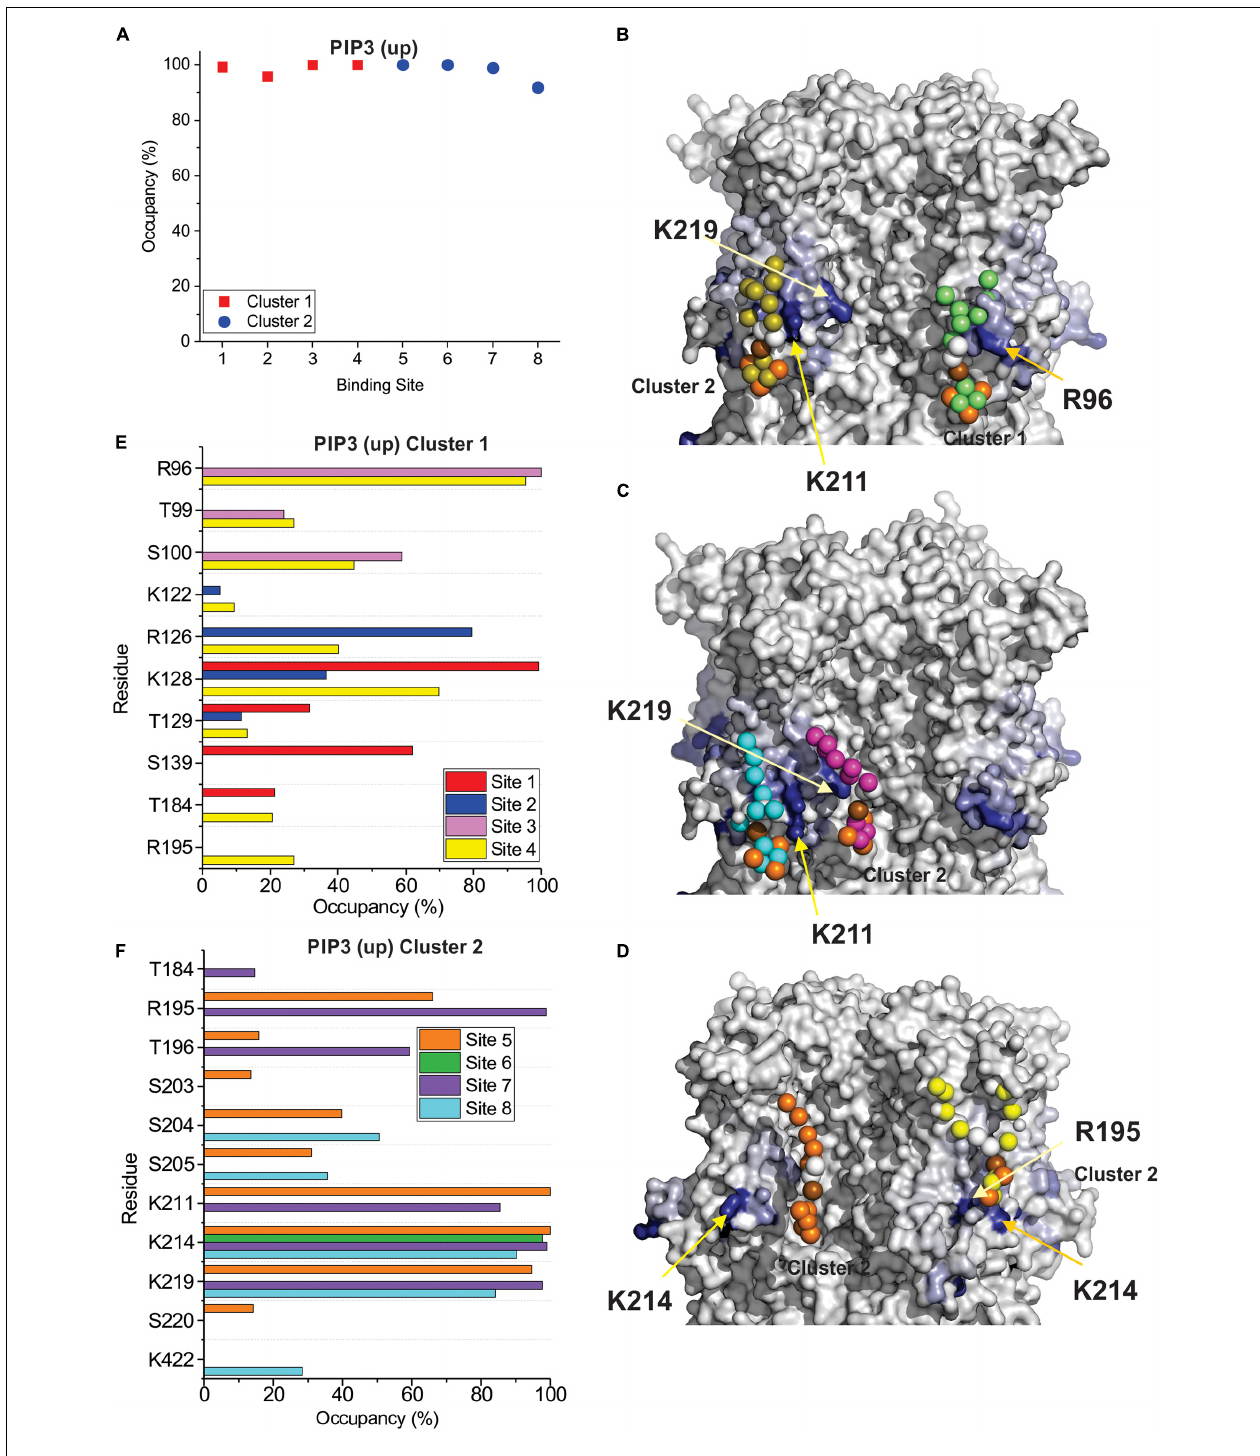
FIGURE 5 | PIP3 binding to HCN1 examined with up (deactivated) VSDs examined by coarse-grained simulations. (A) Occupancy (percentage of frames) of each lipid binding site in the HCN1 tetramer identified and quantified using PyLipid software. Binding sites were clustered according to the commonality of residues involved in binding. Two binding sites for PIP3 were identified. (B–D) Snapshots of PIP3 lipids (colored balls) bound to HCN1 (surface representation). Residues are colored according to occupancy throughout the trajectory from white (0%) to deep blue (100%). Notably, the occupancy of lipid binding is not confined to a few residues, but smeared over a relatively large surface involving numerous residues. (E,F) Occupancy of PIP3-HCN1 interactions for each polar residue. In common with computational docking experiments, binding largely occurred with residues in (E) (cluster 1) the HCN domain (including R96, R126, K128) and (F) in the S2 (R195) and S3 helices (K211, K214, and K219) (cluster 2).